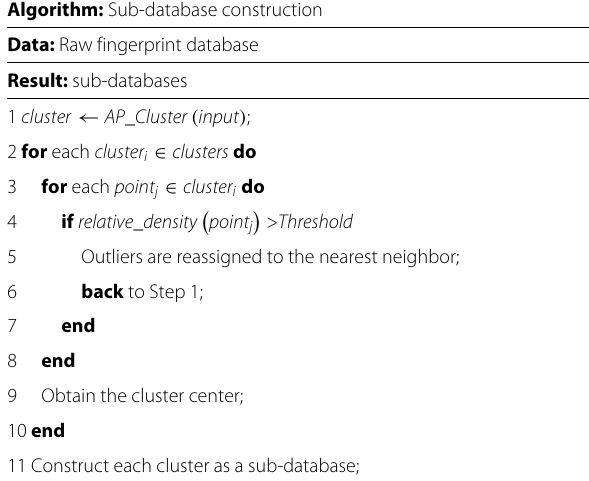
where the notation “ (cid:4)•(cid:4) 2 ” represents the 2-norm opera- tion. D 0 is the anchor location. D i is the i th location of